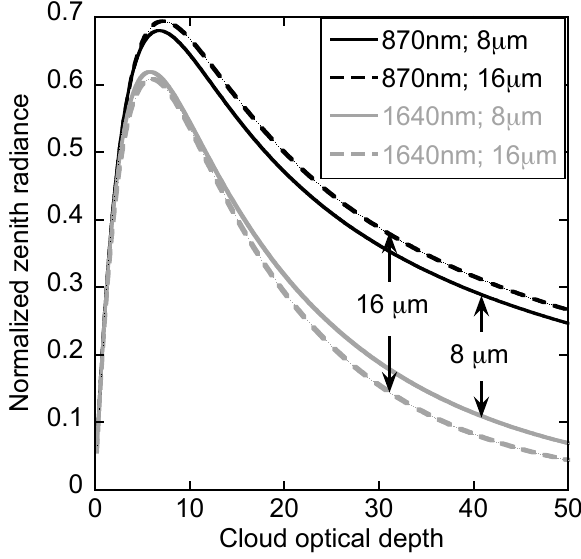
Fig. 3. Dependencies of normalized zenith radiance on cloud op- tical depth at 870 and 1640nm wavelengths for cloud effective droplet size of 8 and 16µm. Surface albedo values are 0.3 at 870nm, and 0.25 at 1640nm. Solar zenith angle is 45°.